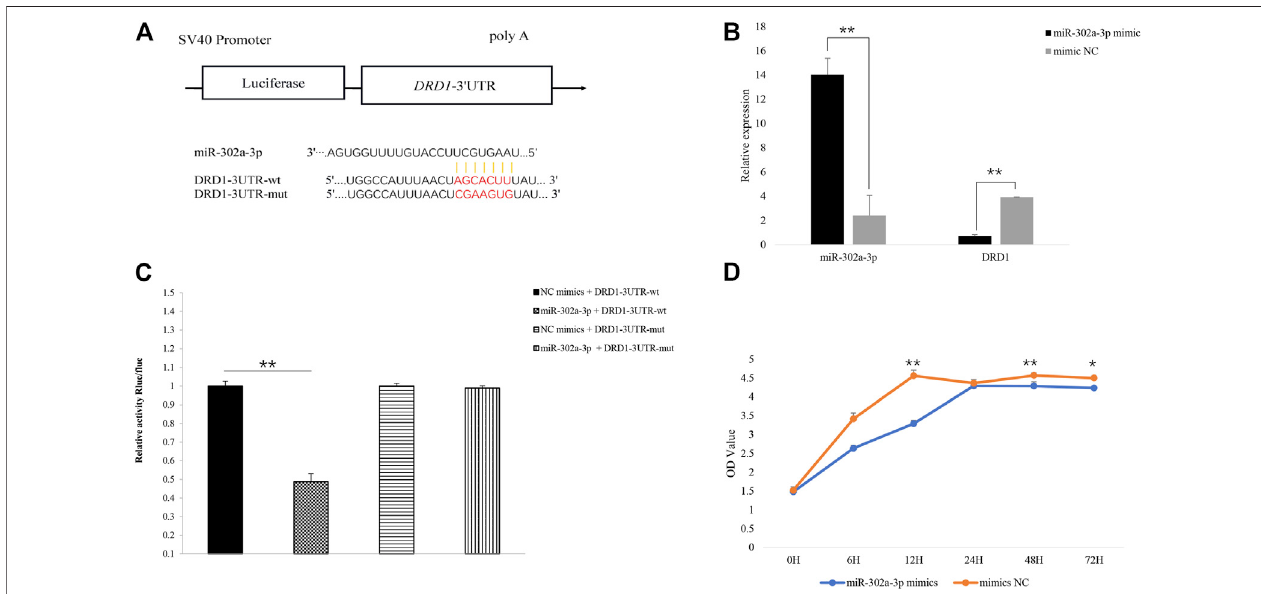
FIGURE5|(A) PredictedbindingsiteofmiR-302a-3ponthe3 ′ UTRof DRD1 andvectorconstruction. (B) OverexpressionofmiR-302a-3pinhibitedtheexpression of DRD1 in chicken granulosa cells. (C) Veri fi cation of miR-302a-3p binding to the 3 ′ UTR of DRD1 using dual-luciferase assay. (D) Overexpression of miR-302a-3p promoted chicken GC proliferation. * p < 0.05, ** p <